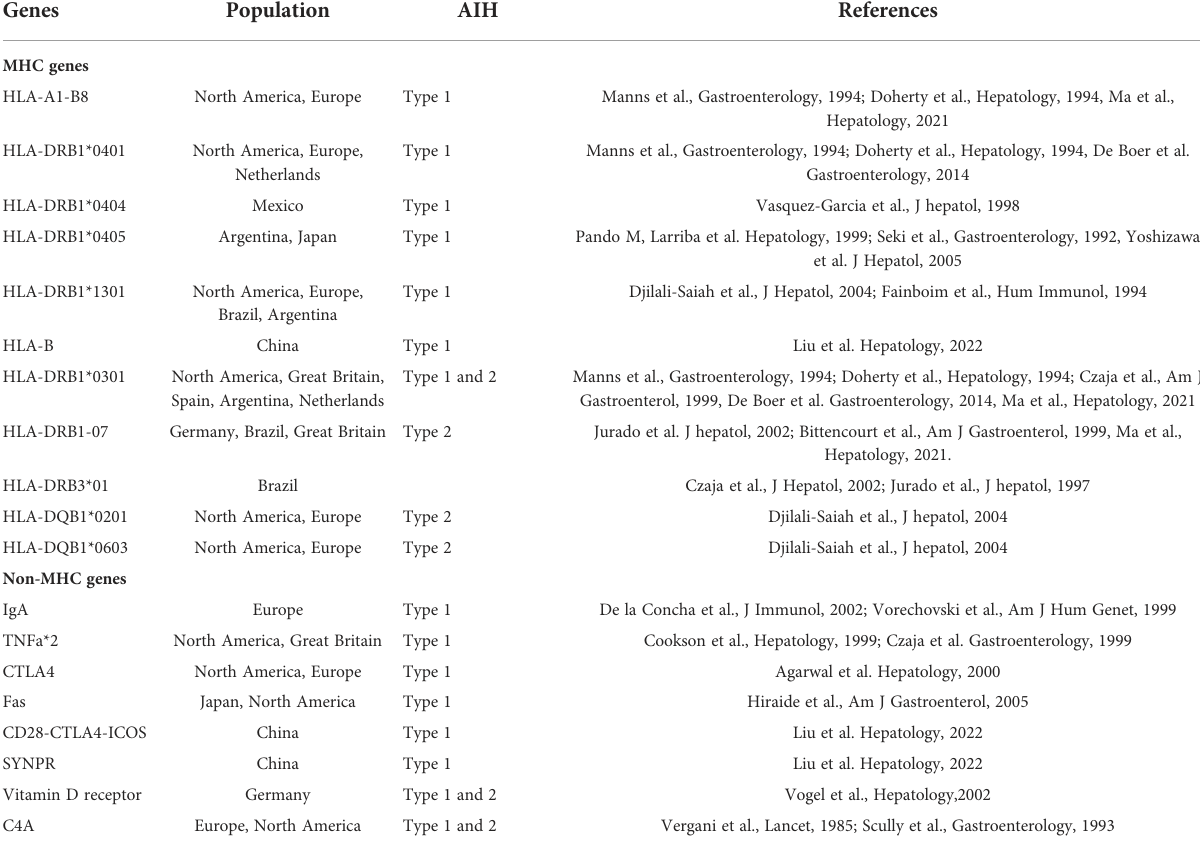
TABLE 2 Susceptibility alleles present in patients with type 1 and 2